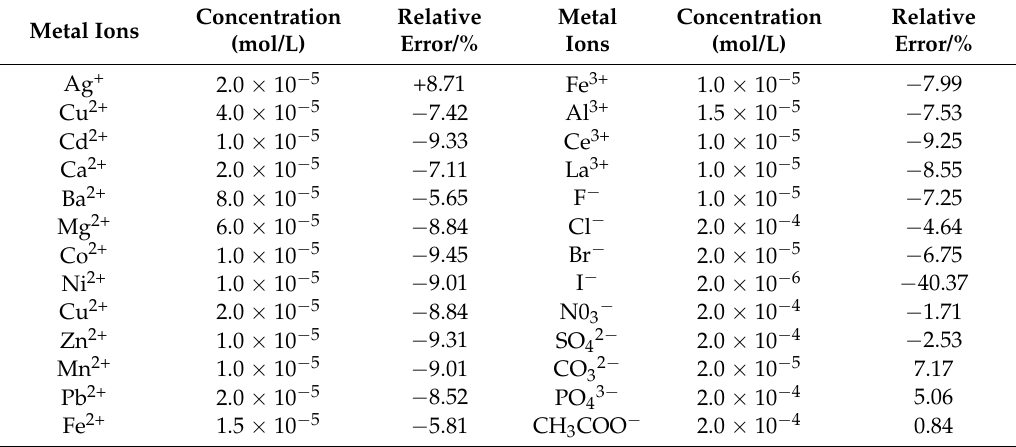
Table 1. Effect of 17 metal ions on the determination of